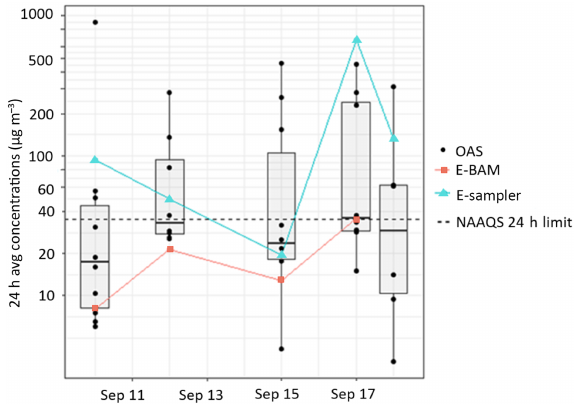
Figure 8. Prescribed fire summary of air quality at all locations for all dates sampled by both OAS and Forest Service equipment (E-BAM and E-SAMPLER). OAS concentrations displayed fit the following criteria: sample more than 75% of 24h sampling period and remain within 20% of desired flow control at all times.